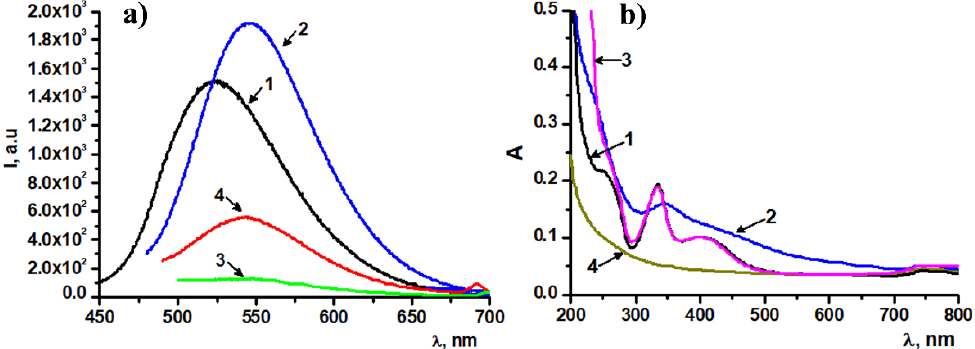
Figure 2. ( a ) Emission spectra of unbound CDs (1, 0.005 gL −1 ) and CDs on the surface of SNs-NH 2 - Cu II (2, 0.05 gL −1 ), SNs-NH 2 (3, 0.05 gL −1 ) and SNs-Cu II (4, 0.05 gL −1 ) in water; ( b ) UV-Vis spectra of water dispersion of CDs (1, 0.02 gL − 1 ), SNs-NH 2 -Cu II -CDs (2, 0.2 gL − 1 ), Cu II -CDs (3, 1.2 mM of CuCl 2 ) and SNs-NH 2 -Cu II (4, 0.2 gL − 1 ).